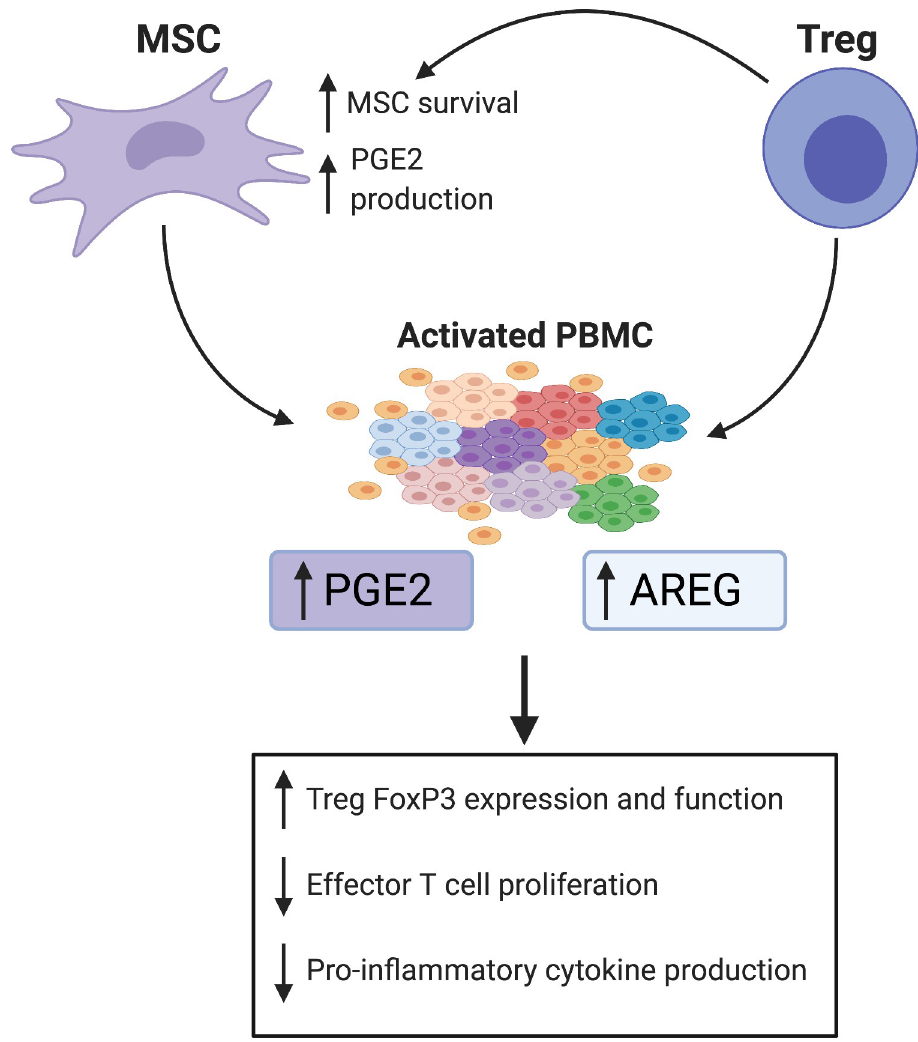
Fig 6. Potential mechanisms of the effects of PGE2 and AREG mediated therapeutic benefit of Treg+MSC combination therapy. PGE2 and AREG have been demonstrated as key mediators of immunomodulation, and our data suggests that MSC and Treg lead to significant increases in PGE2 and AREG production, respectively, in our activated PBMC co-culture. MSC are known to produce PGE2, likely a key determinant of their therapeutic potency [8]. PGE2 has many downstream effects, including polarization of anti-inflammatory, AREG-producing macrophages, induction of FoxP3 expression on Treg and augmentation of suppressive potential, and decreasing effector T